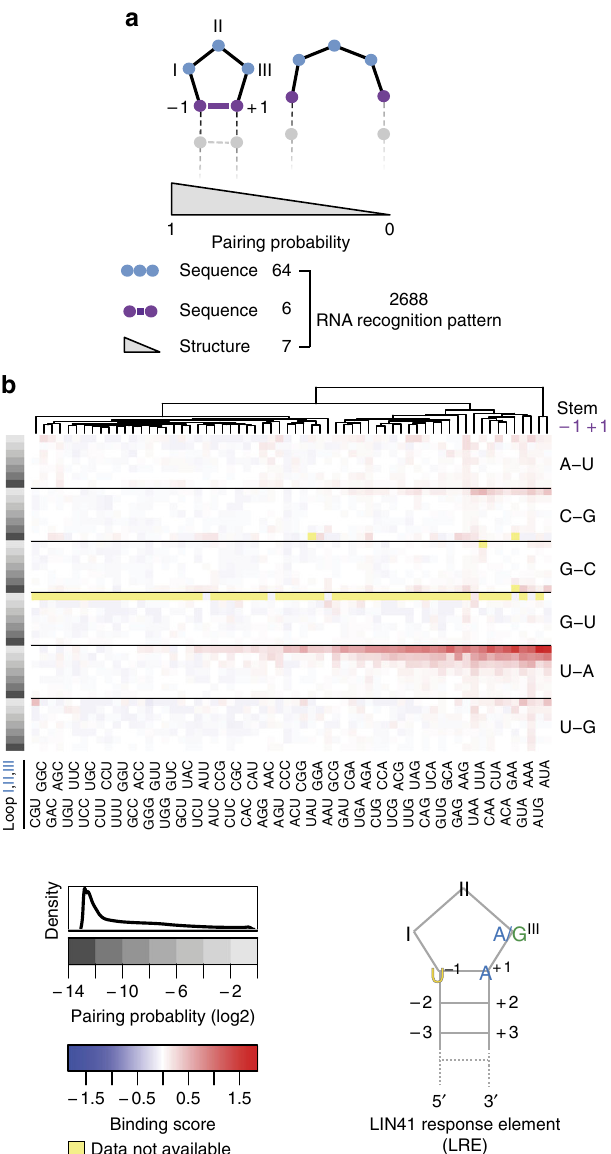
Fig. 6 The LIN41 response element. a Schematics depicting RNA features used to build the LIN41 Response Element (LRE) model. Considered were all possible bases in the three loop positions (I, II, and III) and all possible base pairs at the stem position 1 ( – 1/ + 1). The pairing probability of stem position 1 was determined by the relative occurrence of all possible structures that a particular RNA sequence can acquire. The pairing probabilities were grouped into seven bins on a log2 scale. Combining the sequence and structure features resulted in 2688 (6 × 64 × 7) RNA motif variants. b A heat map showing the average CeLIN41-binding scores from the RNAcompete experiment 17 for all RNAs containing any particular motif variant as described in a . Pairing probability and base pairs at stem position 1 are shown on the left and the right of the heat map respectively. The loop (I, II, and III) sequences are shown in two rows, for clarity, at the bottom of the heat map. The data were clustered based on the CeLIN41-binding score. The overall distribution of pairing probabilities is shown on top of the pairing probability scale. Bottom right: the drawing represents a stem-loop motif, based on the model, referred to as the LIN41 Response Element (LRE). Yellow: data not available (RNA motif variants supported by < 20 oligo